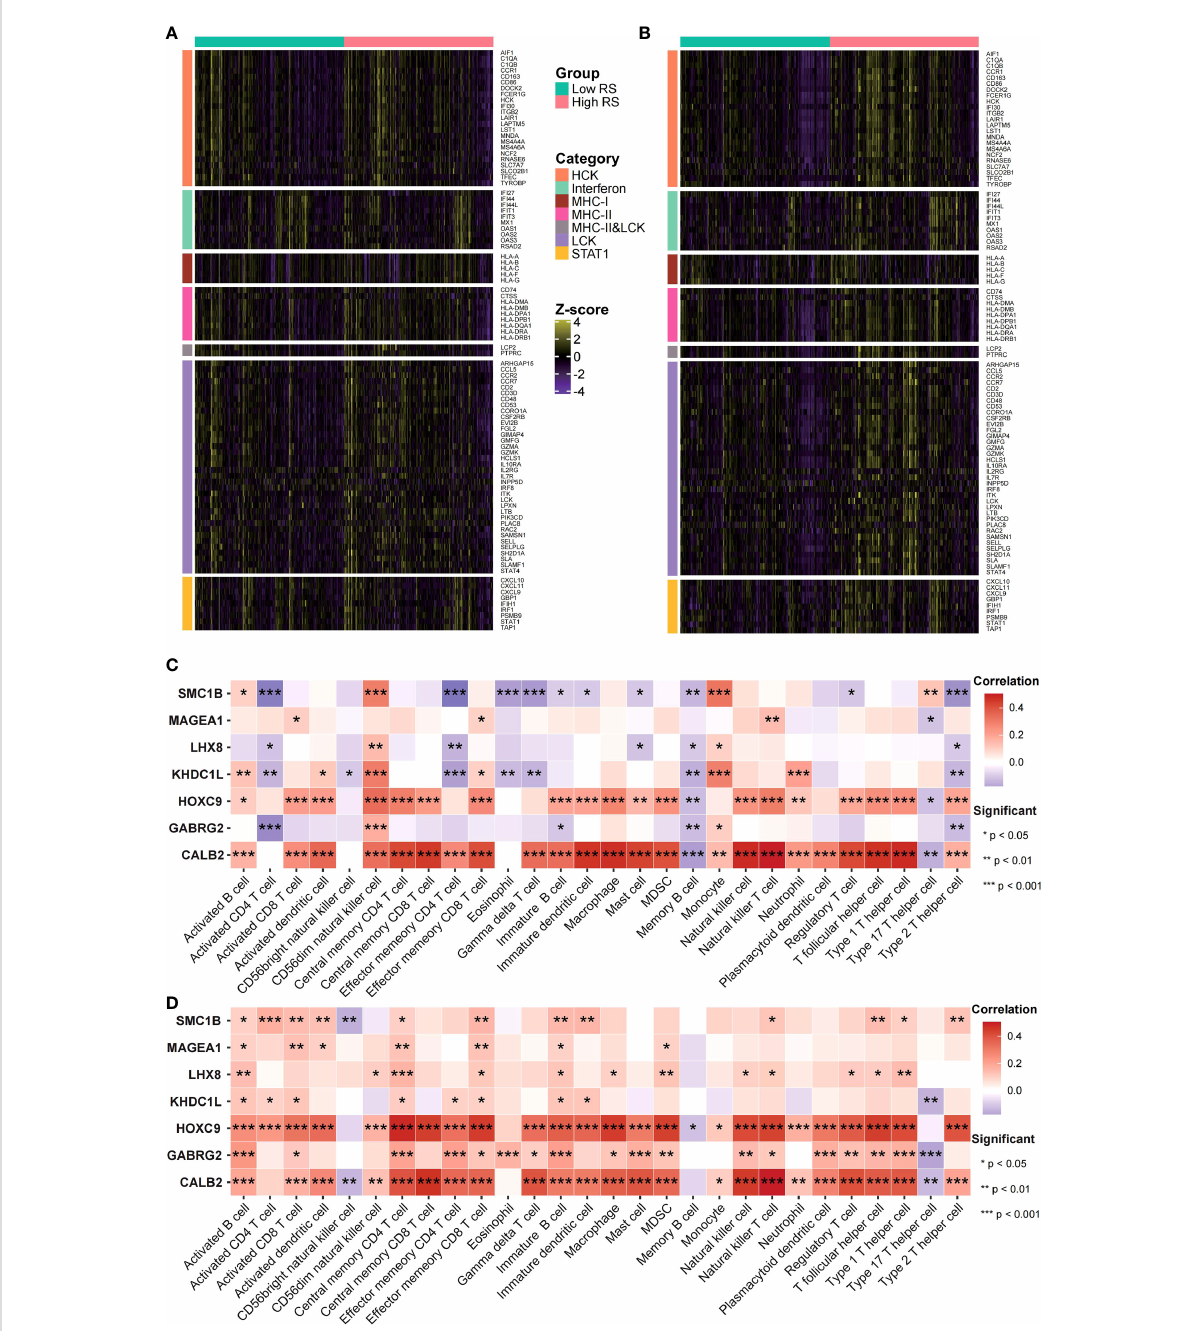
FIGURE 8 Risk scores were related to cancer ’ s immune features. (A, B) Expression status of immune-related genes in GEO (A) and TCGA (B) data sets was analyzed. (C, D) The risk score and immune in fi ltration level correlation in GEO (C) as well as TCGA (D) data sets were